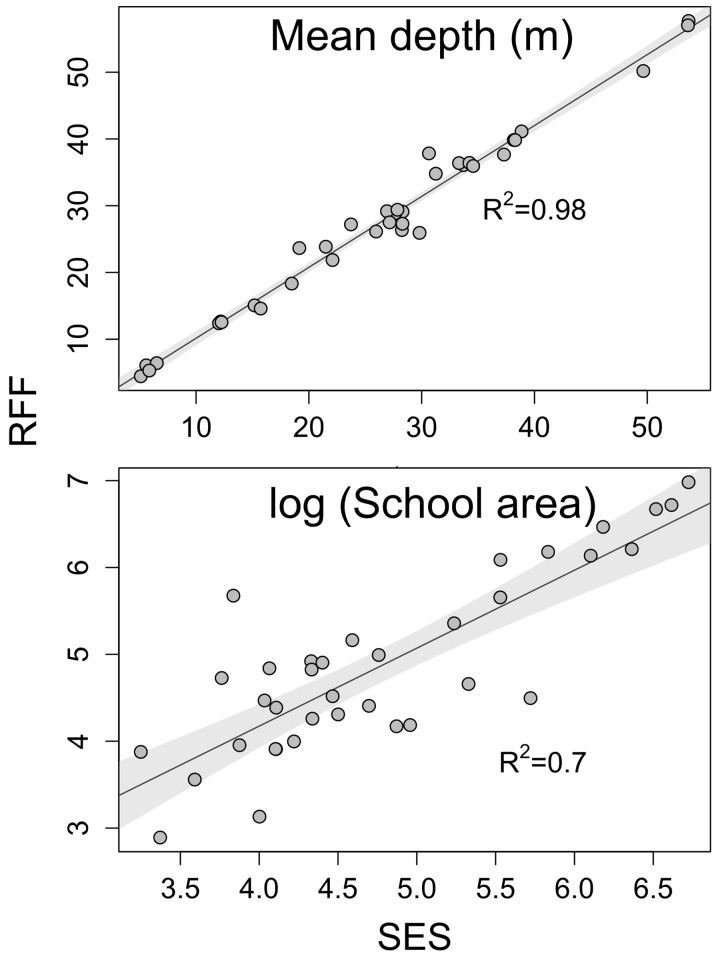
Linear regressions showing the relationships between school desciptors, mean depth (top graph) and log transformed school area (bottom graph), for 36 matched schools from the recreational fish-finder (RFF) and the scientifc echo-sounder (SES).Shaded areas denote 95% confidence intervals.